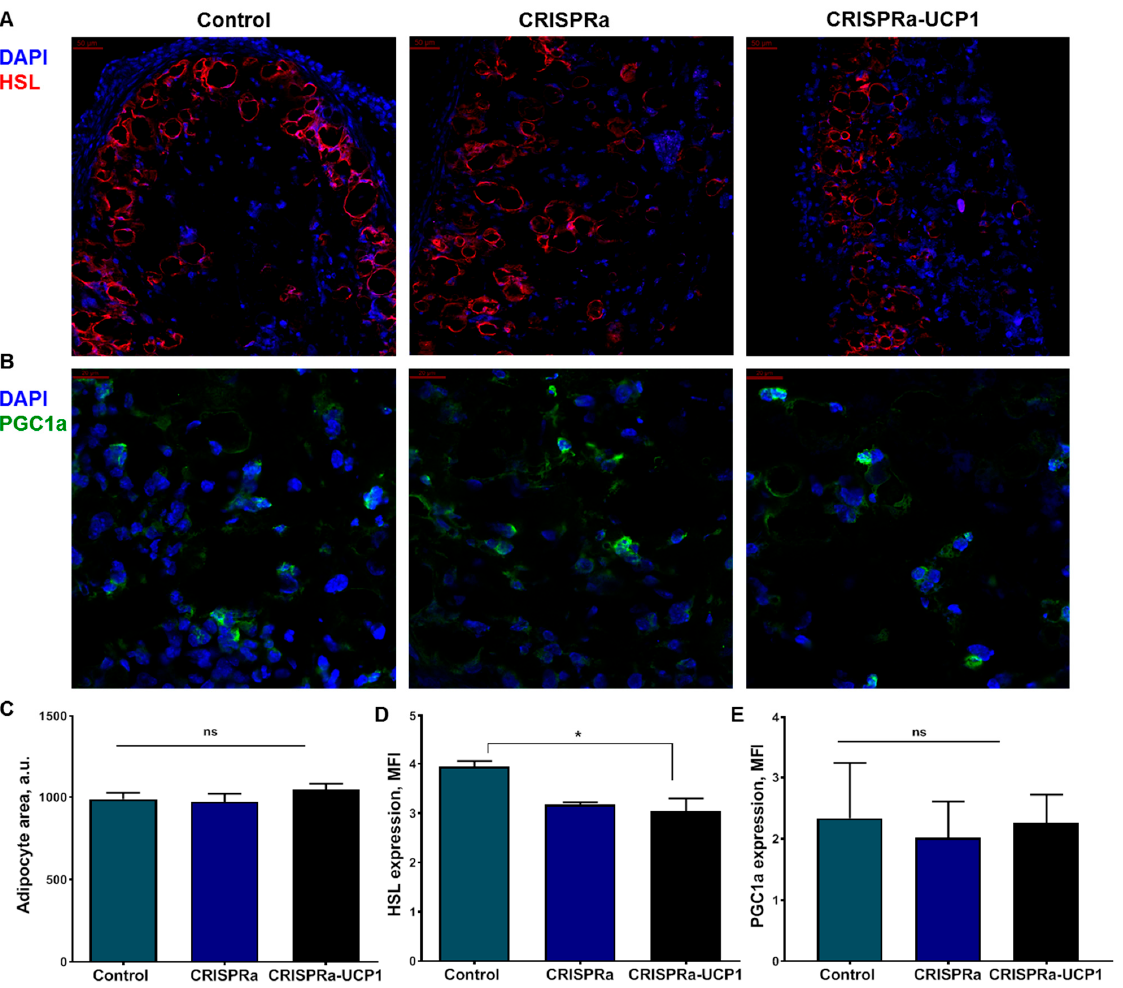
Figure 3. CRISPRa system does not influence adipocyte size or expression of HSL or PGC1 α . ( A ) Representative images of graft sections stained for HSL and DAPI, scale bar 50 μ m; ( B ) representative images of graft sections stained for PGC1 α and DAPI, scale bar 20 μ m; ( C ) quantification of average adipocyte area in sections stained for HSL; ( D ) quantification of HSL expression in adipocytes; ( E ) quantification of PGC1 α expression in adipocytes. DAPI—4 ′ ,6-diamidino-2-phenylindole; HSL—hormone sensitive lipase; MFI—mean fluorescence intensity; PGC1 α —peroxisome proliferator-activated receptor gamma coactivator-1 α . Data are represented as mean ± SEM, Kruskel–Wallis test with post-hoc Dunn’s test, *—significance threshold p < 0.05. ns—non-significant difference.